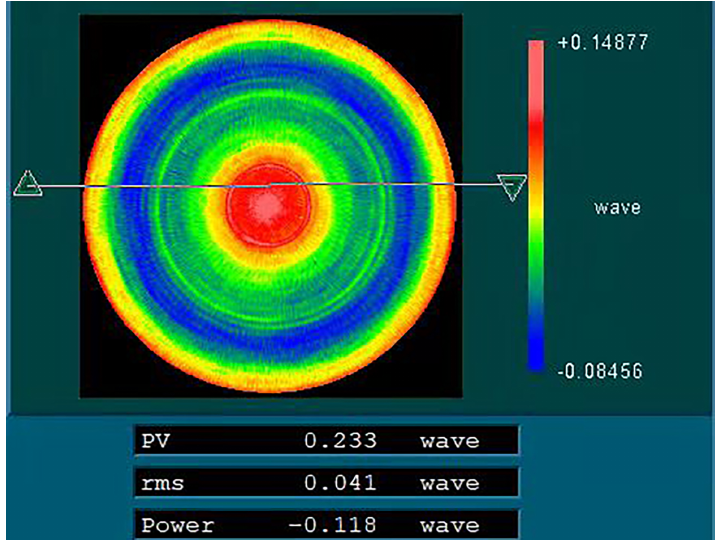
Figure 14. Surface-shape accuracy test of 260 mm aperture aluminum alloy